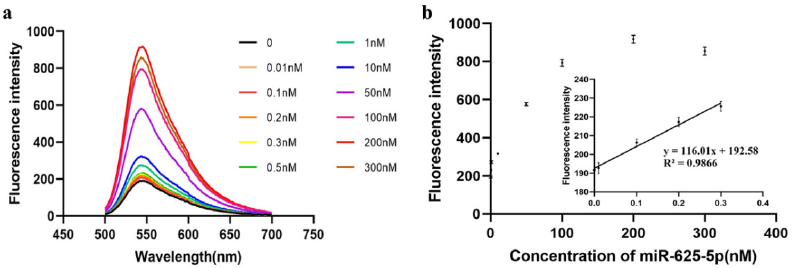
Figure 6. Determination of the detection range and limit. ( a ) The fluorescence emission spectra of samples with different concentrations of miR-625-5p ranging from 0 to 300 nM; ( b ) the plot of correlation between the concentration of miR-625-5p and the fluorescence intensity. The inset showed the concentration ranging from 0.01 to 0.3 nM had a linear relationship with the fluorescence intensity. The fluorescence intensities of different concentrations are presented as mean ± SD. Each assay was performed in